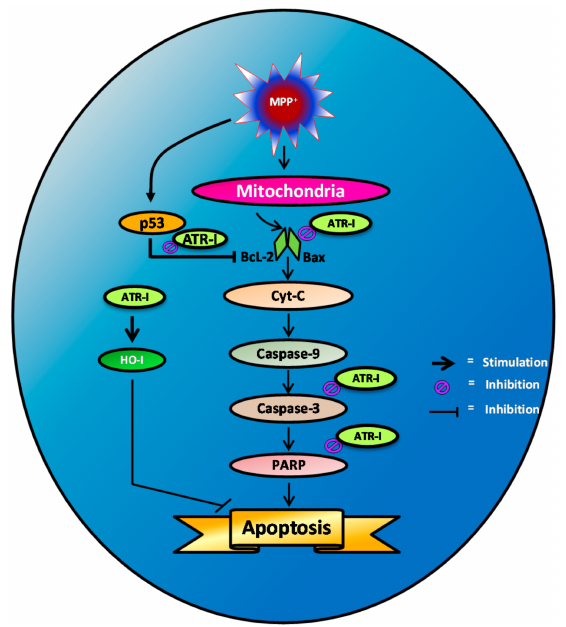
Figure 6. Scheme representing MPP + -induced apoptotic